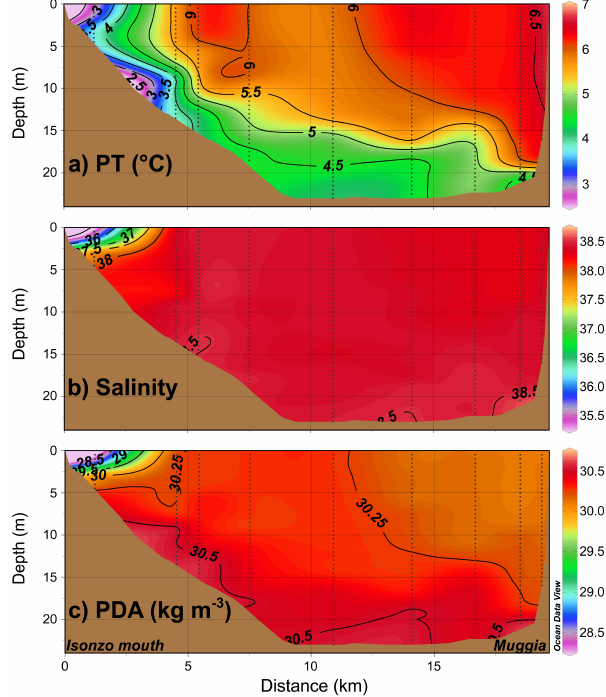
Fig. 3. Distribution of (a) potential temperature (PT, in ◦ C), (b) practical salinity and (c) potential density anomaly (PDA, in kgm − 3 ) measured in the Gulf of Trieste between 14 and 16 Febru- ary 2012. The mouth of the Isonzo River is at the northwestern part of the transect. See the smaller inset in Fig. 1 for transect